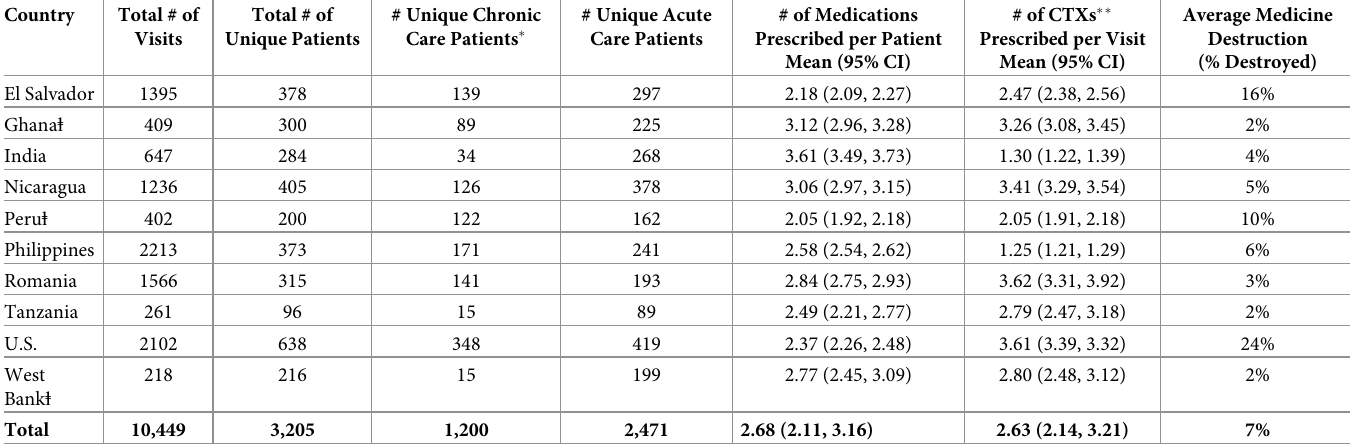
Table 1. Characteristics of study clinics by